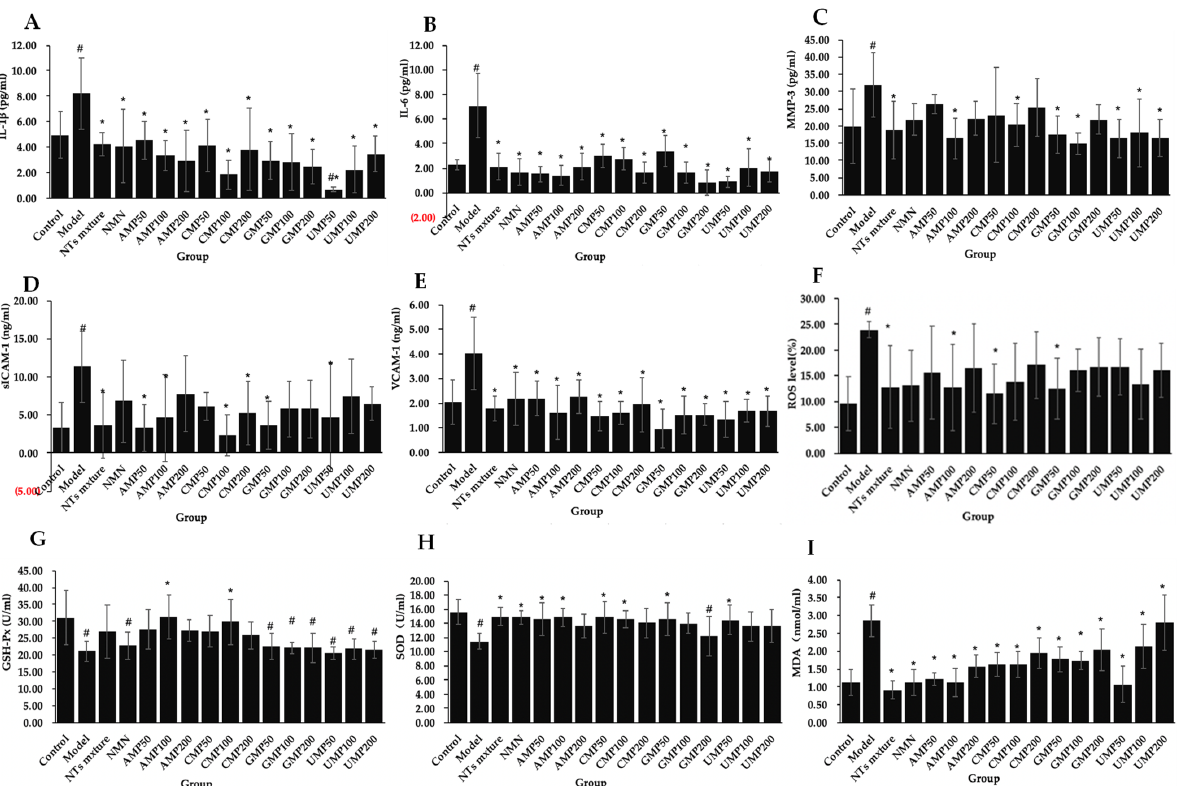
Figure 2. ( A ) The effect of NTs on the secretion of IL ‐ 1 𝛽 in H 2 O 2 ‐ treated PC ‐ 12 cells; ( B ) The effect of NTs on the secretion of IL ‐ 6 in H 2 O 2 ‐ treated PC ‐ 12 cells; ( C ) The effect of NTs on the secretion of MMP3 in H 2 O 2 ‐ treated PC ‐ 12 cells; ( D ) The effect of NTs on the secretion of sICAM ‐ 1 in H 2 O 2 ‐ treated PC ‐ 12 cells; ( E ) The effect of NTs on the secretion of VCAM ‐ 1 in H 2 O 2 ‐ treated PC ‐ 12 cells; ( F ) The effect of NTs on the intracellular ROS production in H 2 O 2 ‐ treated PC ‐ 12 cells; ( G ) The effect of NTs on the GSH ‐ Px activities in H 2 O 2 ‐ treated PC ‐ 12 cells; ( H ) The effect of NTs on the SOD activities in H 2 O 2 ‐ treated PC ‐ 12 cells; ( I ) The effect of NTs on the MDA levels in H 2 O 2 ‐ treated PC ‐ 12 cells ( n = 3 per group). # p < 0.05 versus control group, * p < 0.05 versus model